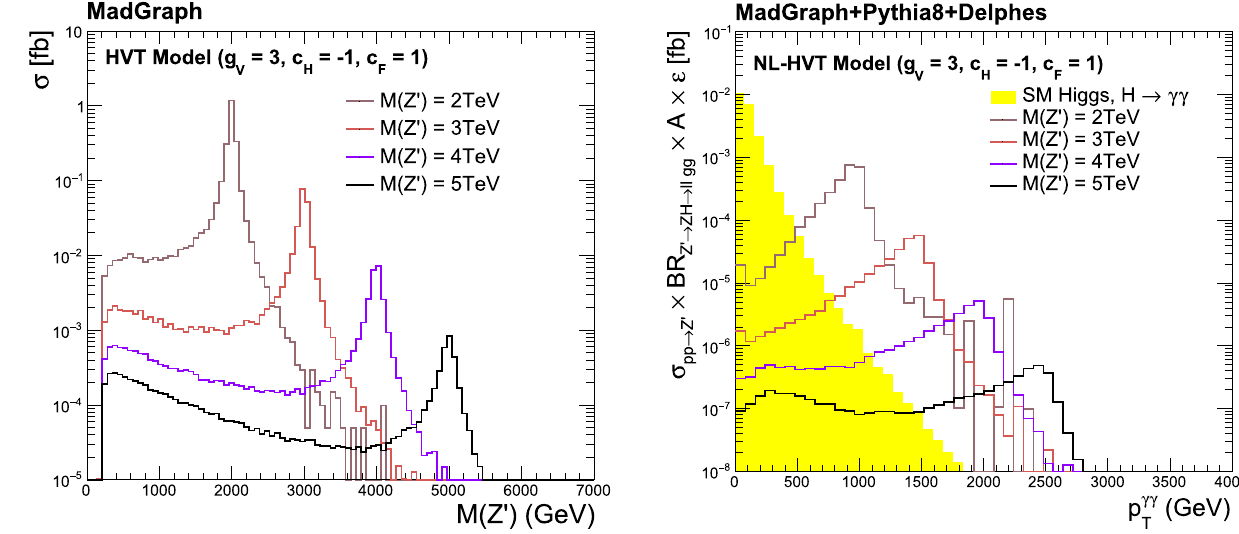
Fig. 3 Leading order Z (cid:2) resonance differential cross sections d σ/ dM ( Z (cid:2) ) as predicted from the HVT model